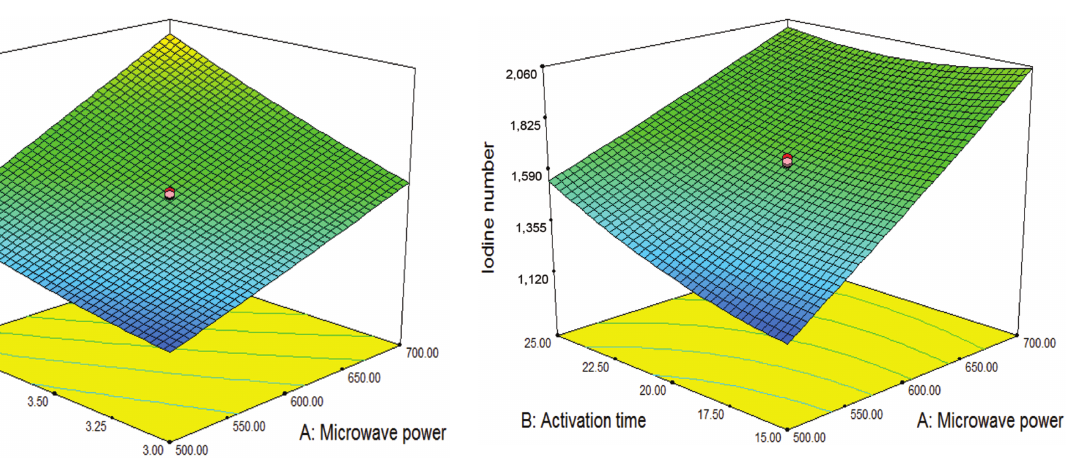
Figure 2: Three-dimensional response surface plot of iodine number: effect of microwave power and IR on iodine number (activation time: 20min).